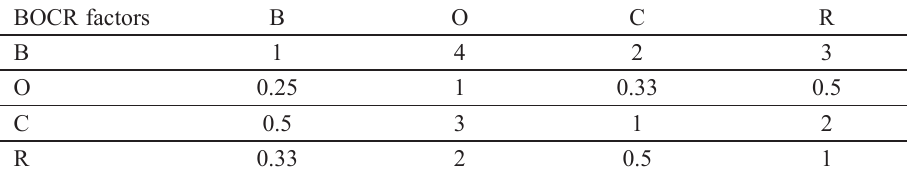
Table 2. A sample of comparison matrix for the BOCR factors BOCR